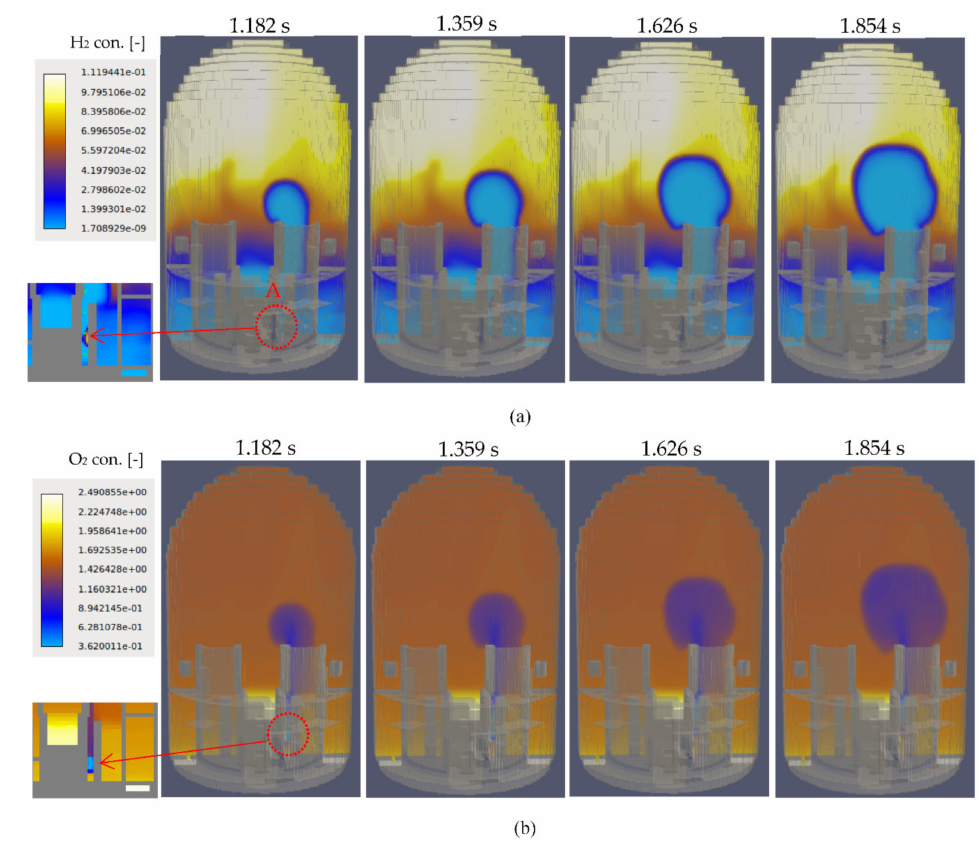
Figure 9. Calculated gas concentrations according to time variation. ( a ) Hydrogen. ( b )